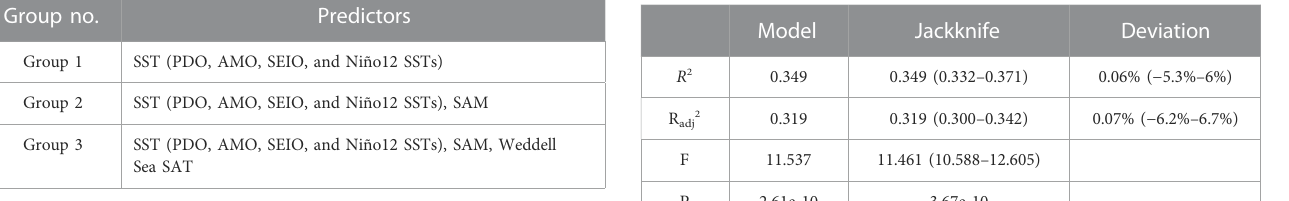
TABLE 2 Statistical parameters for the model including SST, SAM, and SAT and the test results of the jackknife